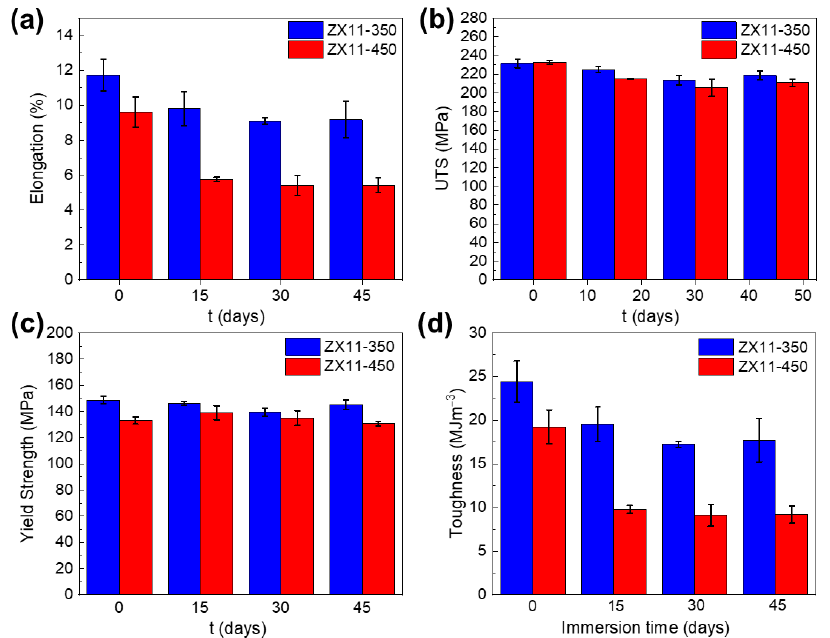
Figure 6. Tensile test experimental results for ( a ) elongation, ( b ) ultimate tensile strength (UTS) ( c ) yield strength, and ( d ) toughness as a function of immersion time.